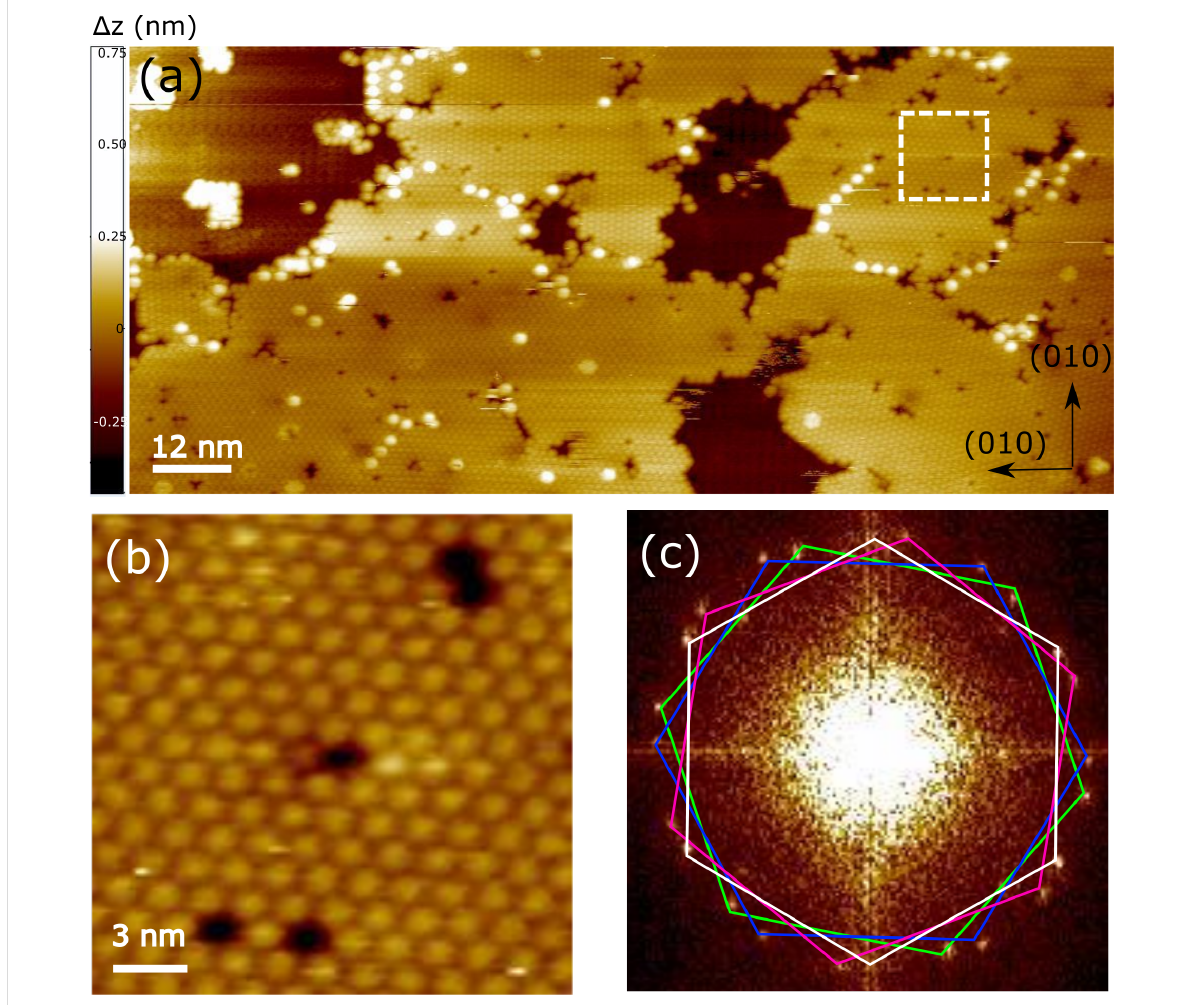
Figure 2: (a) Large-scale STM image of a C 60 wetting layer deposited on C 60 /Zn-TPP/Fe(001)- p (1 × 1)O. In the left top corner of the image, the ZnTPP layer is visible. (b) Zoomed image of the region marked by a dashed square in panel (a). (c) FFT of the image in panel (a), where four differ- ently oriented hexagonal domains are marked. The rotation angles between the white and the pink, blue, and green hexagonal domains are 10°, 33°, and 44°, respectively. STM images have been acquired at V = 1.5 V and I = 500